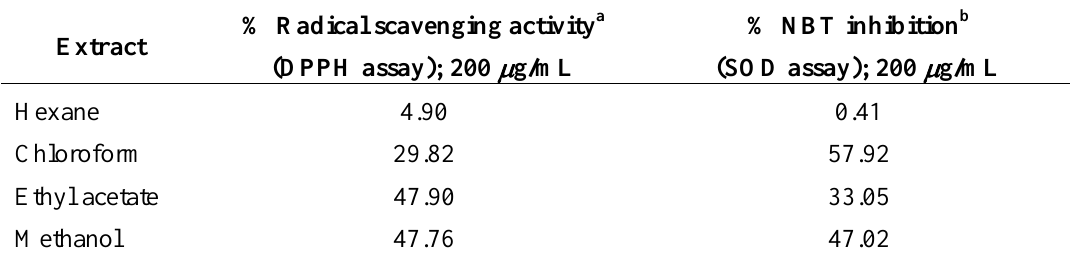
Table 5. Radical scavenging activity and NBT inhibition of